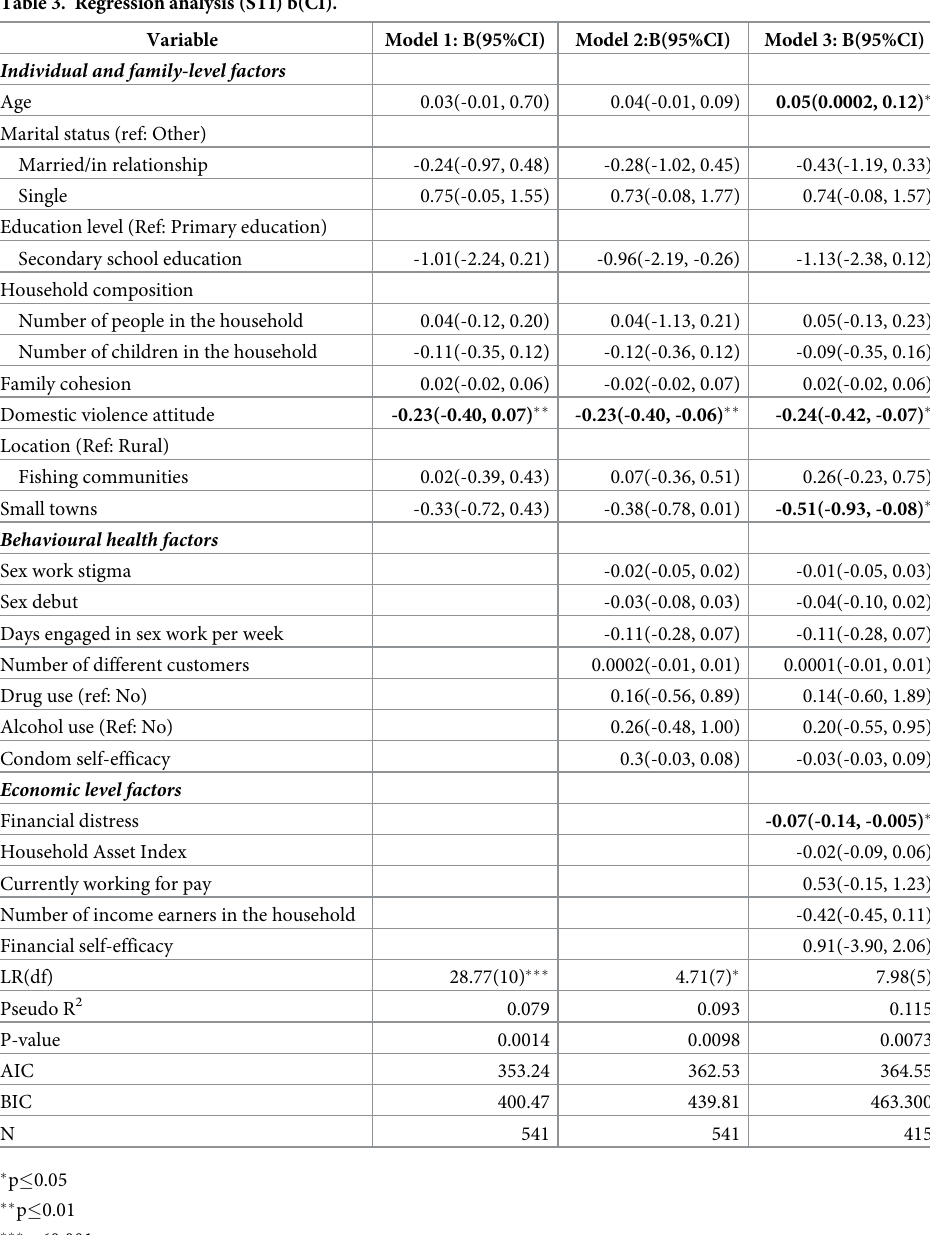
Table 3. Regression analysis (STI)